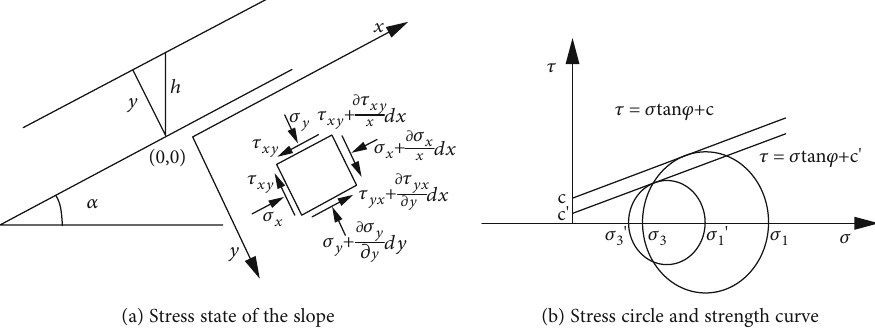
Figure 1: The stress state of a slope and the e ff ect of water pressure on the strength